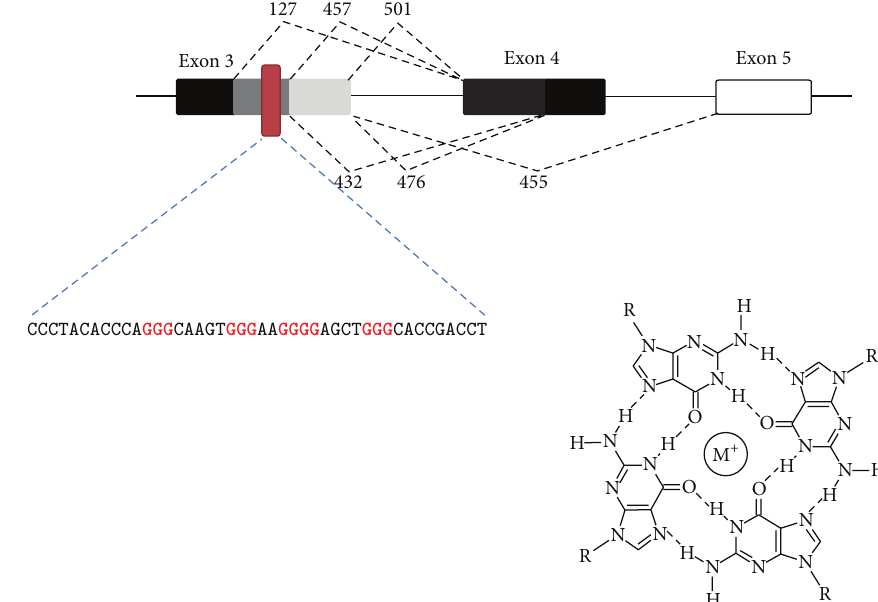
Figure 8: Site of four successive GGG motifs in exon 3 of BACE1 mRNA and alternative splice sites. These motifs fold into a G-quadruplex structure, with stacked sets of four planar guanine rings stabilized by Hoogsten base pairing and a K+ ion.